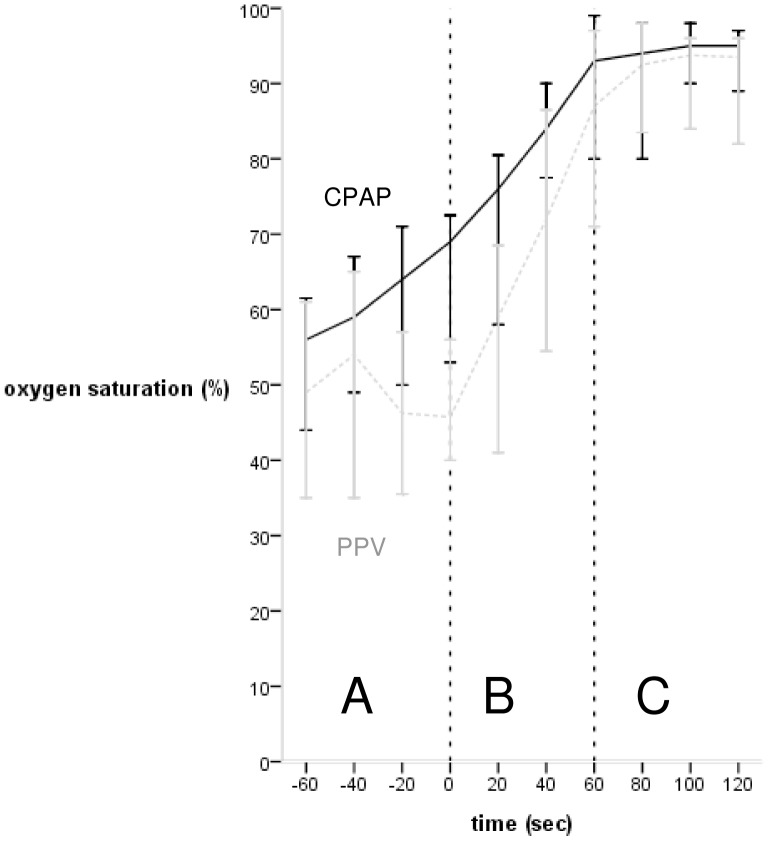
Oxygen saturation (%) of infants on CPAP and infants needing PPV in the minute before and 2 minutes after start of FiO2 1.0.Black = CPAP-group, light grey = PPV-group, (A) minute before start FiO2 1.0, (B) first minute after start FiO2 1.0, (C) second minute after start FiO2 1.0.